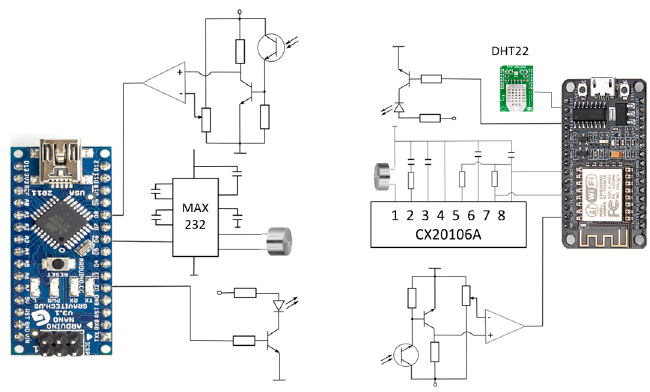
Figure 5. Electronic diagram of the implemented system, base ( left ) and remote ( right ) stations.